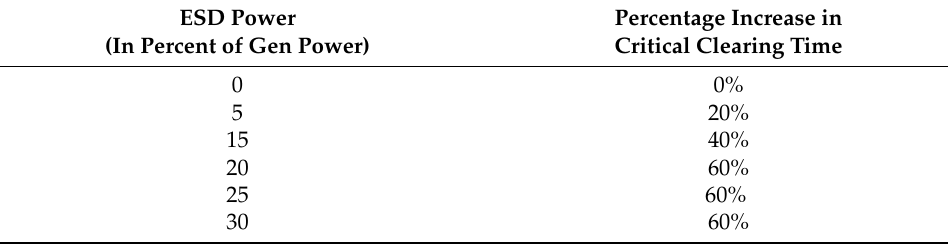
Table 4. Gained critical clearing time. ESD